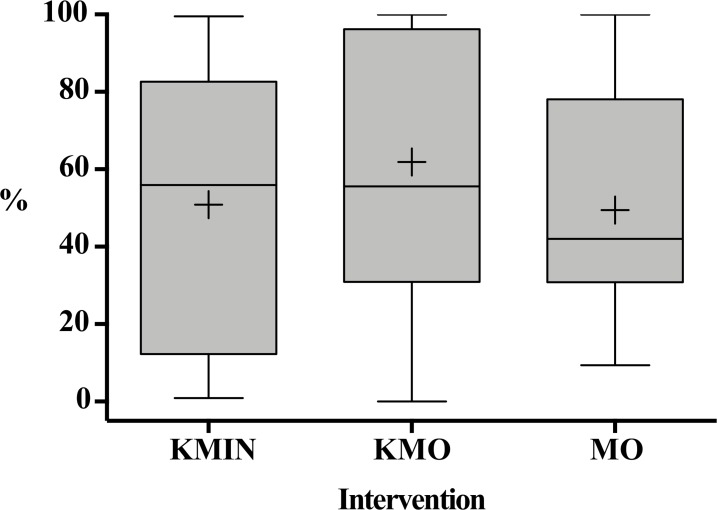
Percentage of quiet behavior in the sedative groups reported as minimum to maximum values, medians, quartiles and means (+).KMIN = Intranasal ketamine–midazolam; KMO = Oral ketamine and midazolam; MO = Oral midazolam.